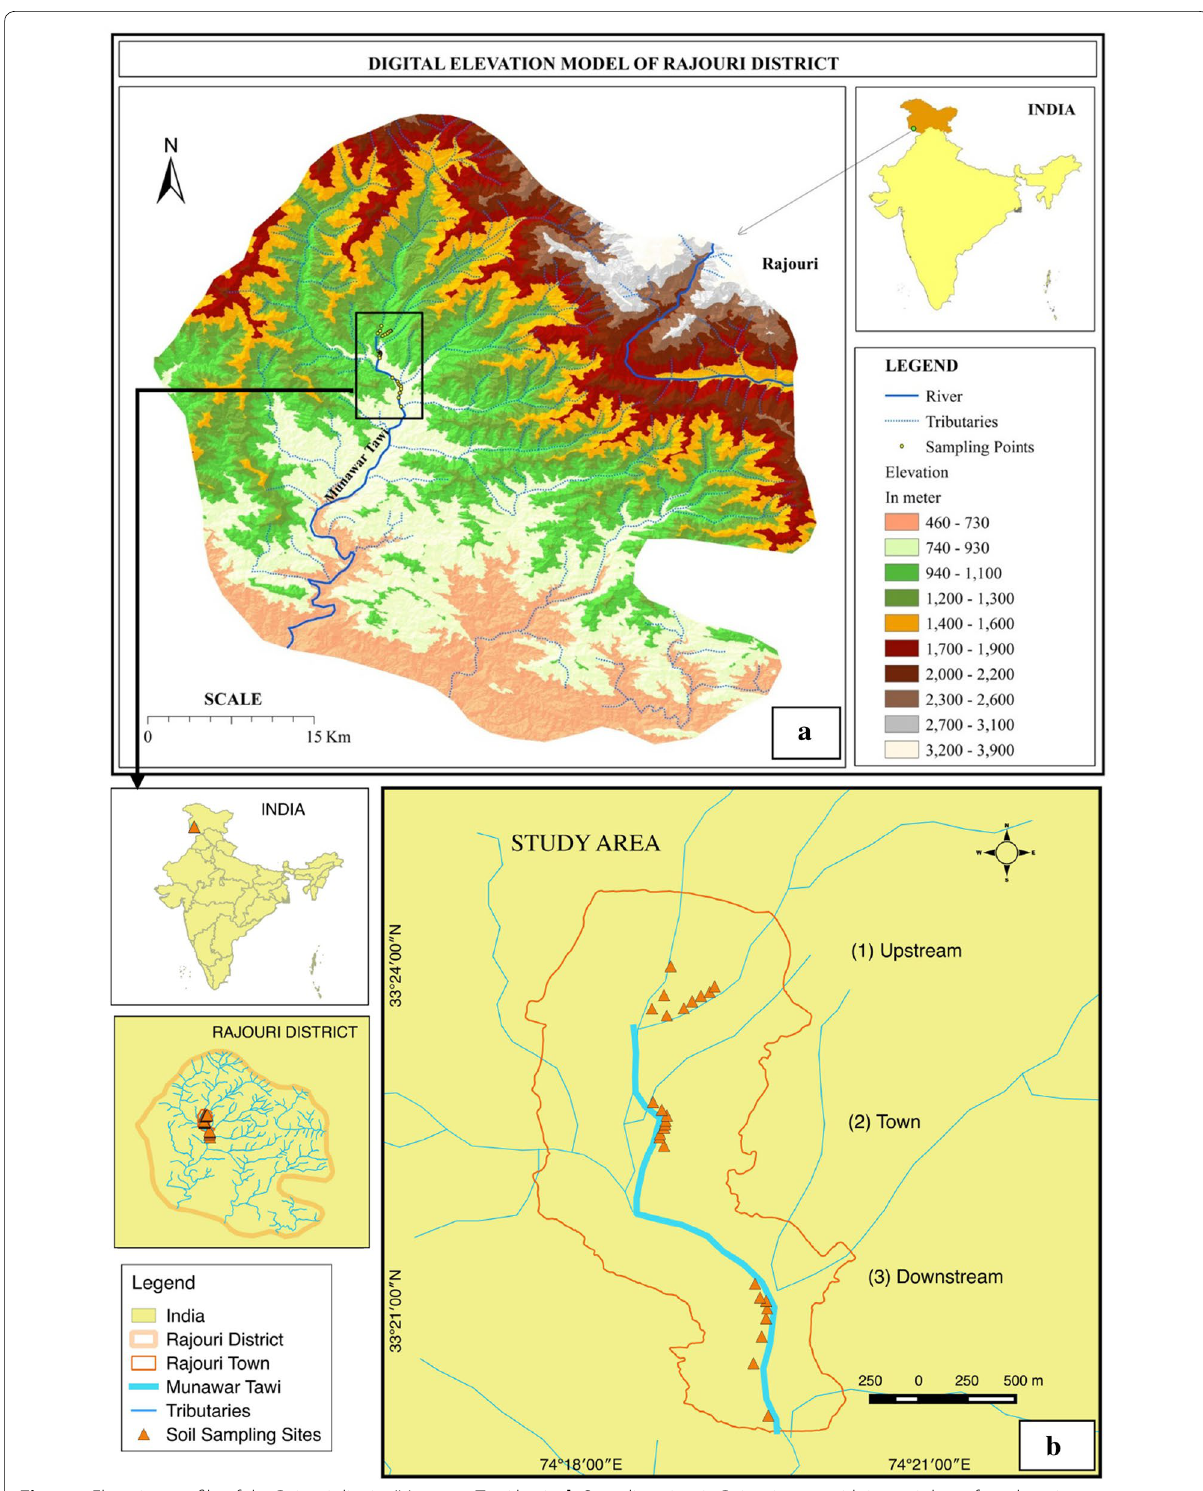
Fig. 1 a Elevation profile of the Rajouri district/Munawar Tawi basin. b Sampling sites in Rajouri town with its periphery, from location one ( upstream ) to two (highly populated area) and three ( downstream